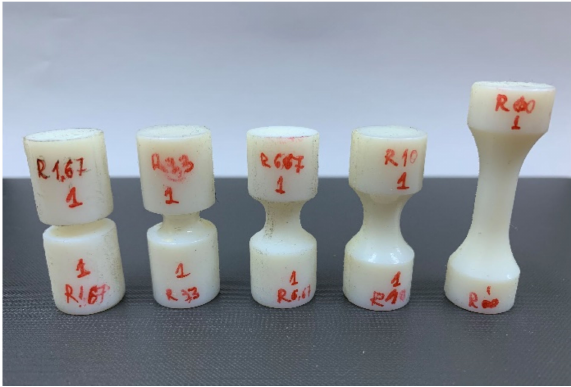
Figure 7. Cylindrical specimens used in upsetting tests.